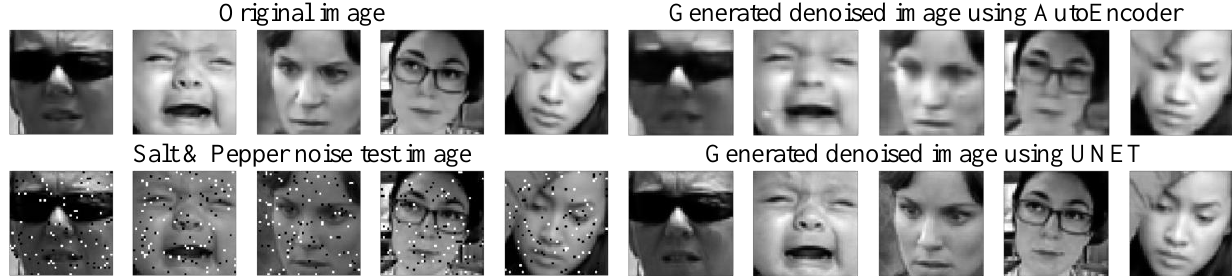
Figure 9. FER2013 images (a) original Image (b) Salt&Pepper noised image with noise factor of 0.05 (c) denoised image with AutoEncoder (d) denoised image with